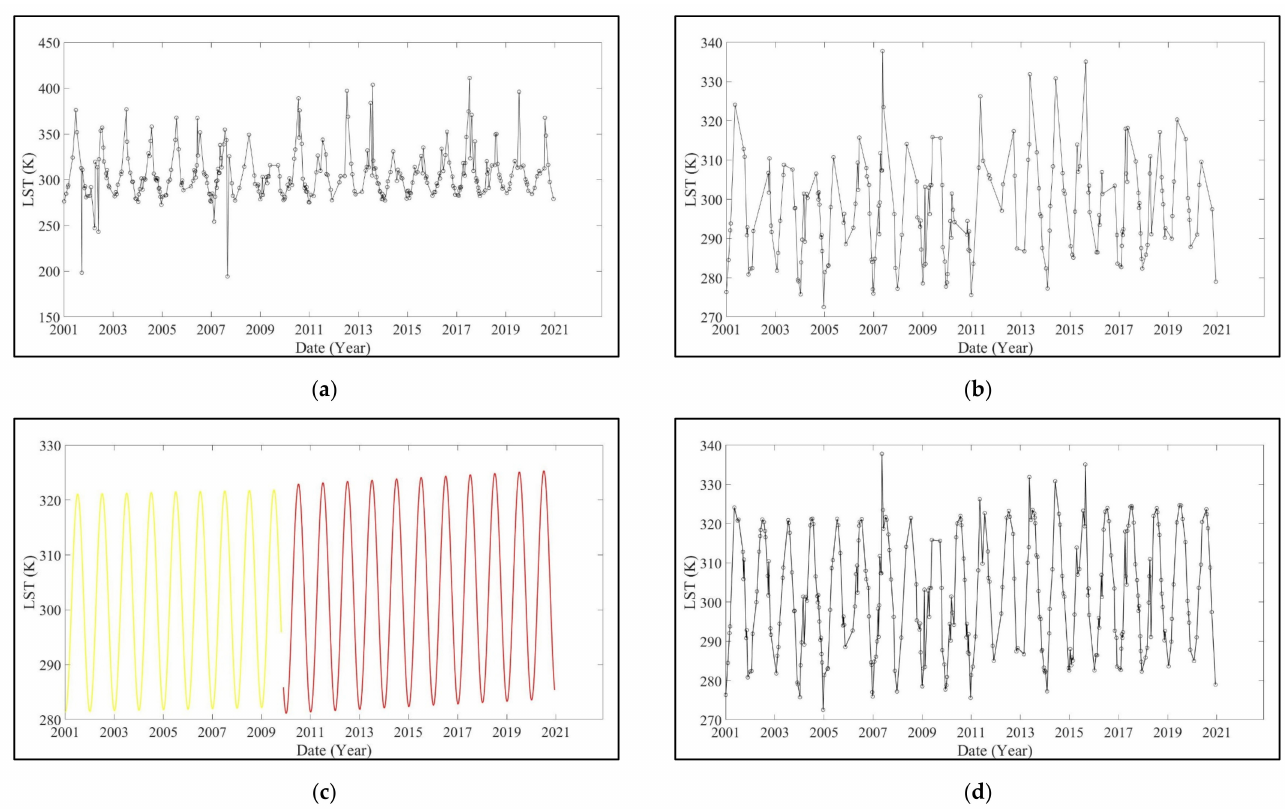
Figure 11. Primary calculation process and results of one pixel. ( a ) Estimated LST values (305 scenes); ( b ) estimated LST data after ignoring contaminated values (185 scenes); ( c ) simulated LST recalculated using HA for each period based on harmonic terms (305 scenes); and ( d ) reconstructed time-series LST (305